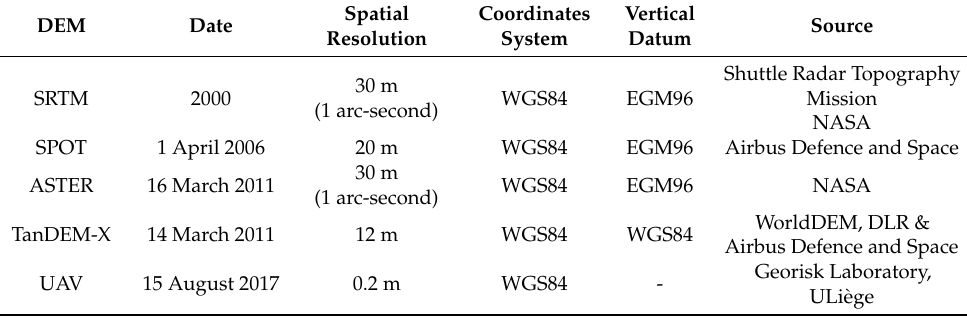
Table 1. Properties of the DEMs collected for the Mailuu-Suu area (N41E072) since